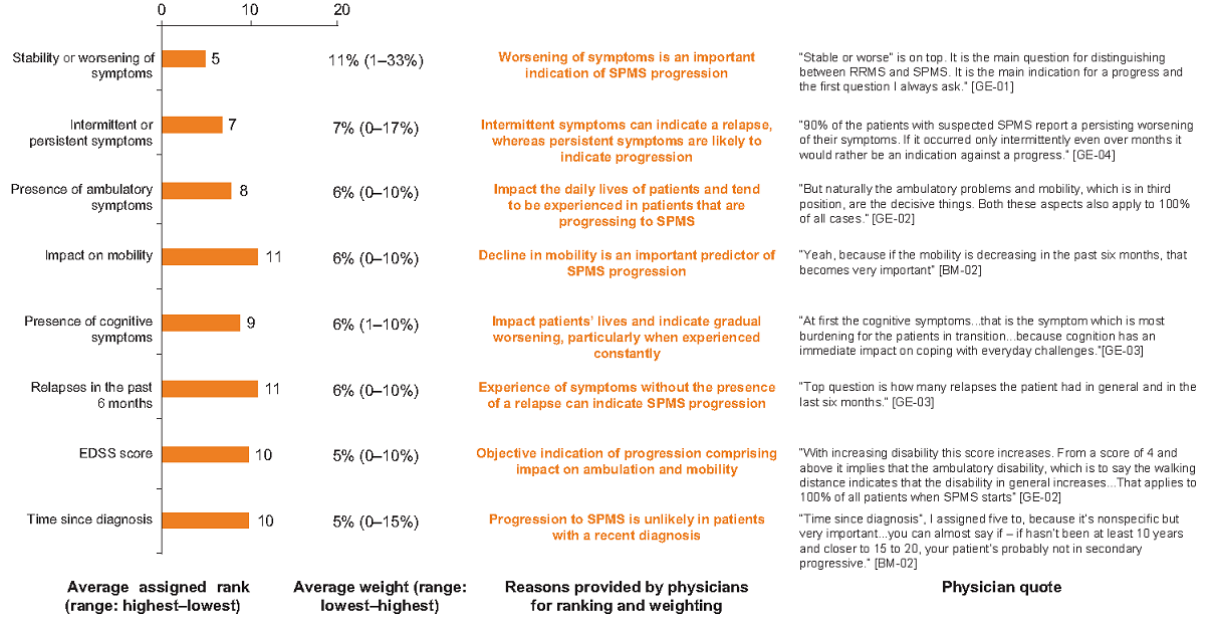
Figure 4. Variables of high importance in progression to secondary progressive multiple sclerosis. Ranking out of 26 variables included. Lower ranking indicates greater importance. EDSS: Expanded Disability Status Scale; RRMS: relapsing-remitting multiple sclerosis; SPMS: secondary progressive multiple sclerosis.